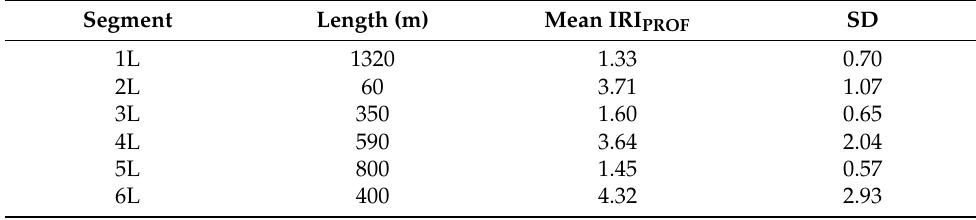
Table 4. Segment characterization (left wheel